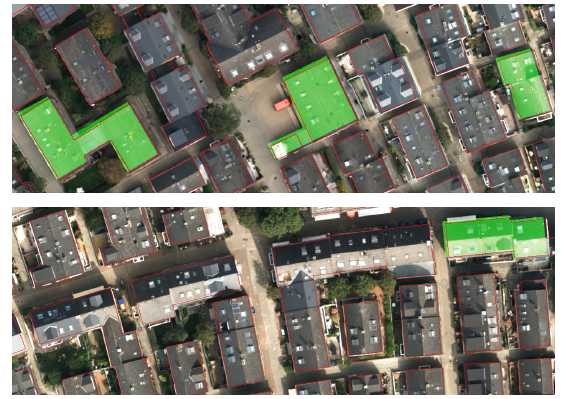
Figure 5. Comparison of the building outlines without roof overhangs (transparent green) and the cadastral map (red)